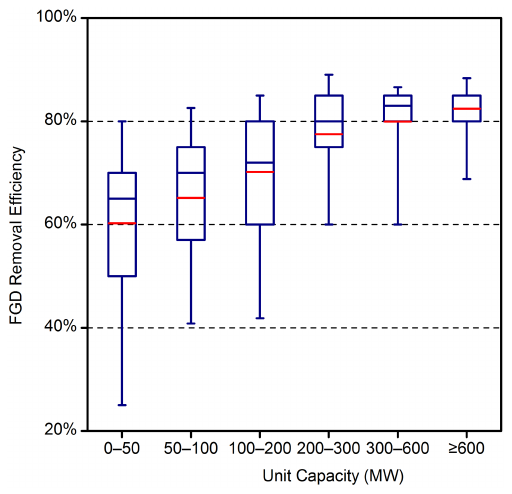
Figure 5. Distributions of FGD penetration for electric generating units of various ages in 2006, 2008, and 2010.